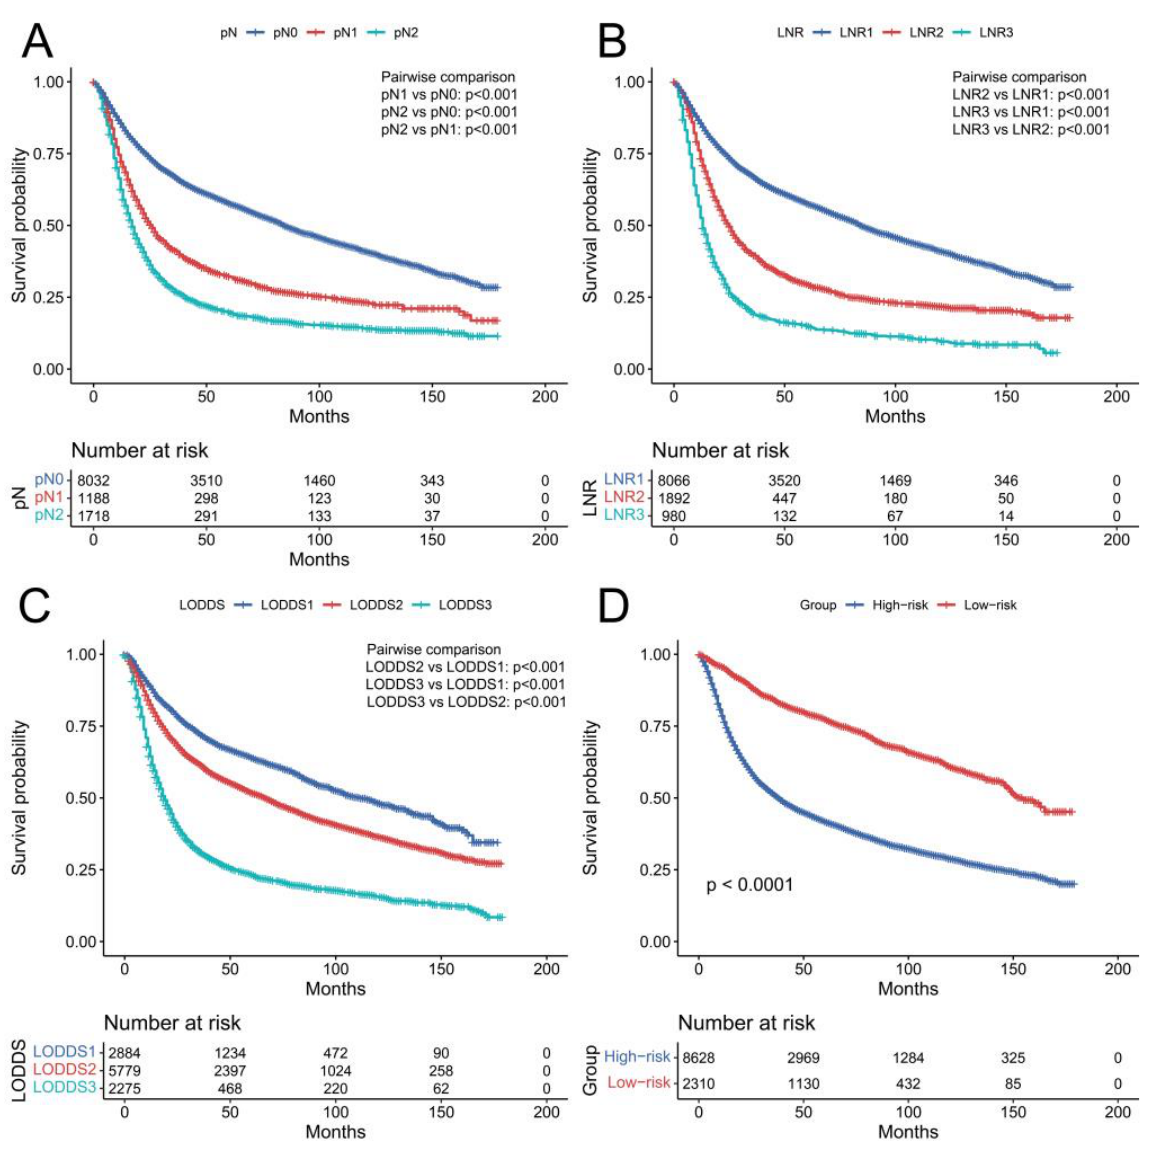
Figure 2. Kaplan–Meier curves of overall survival in the overall cohort according to pN ( A ), LNR ( B ), LODDS ( C ), and risk group ( D ). pN: pathological N status; LNR: lymph node ratio; LODDS: log odds of positive lymph